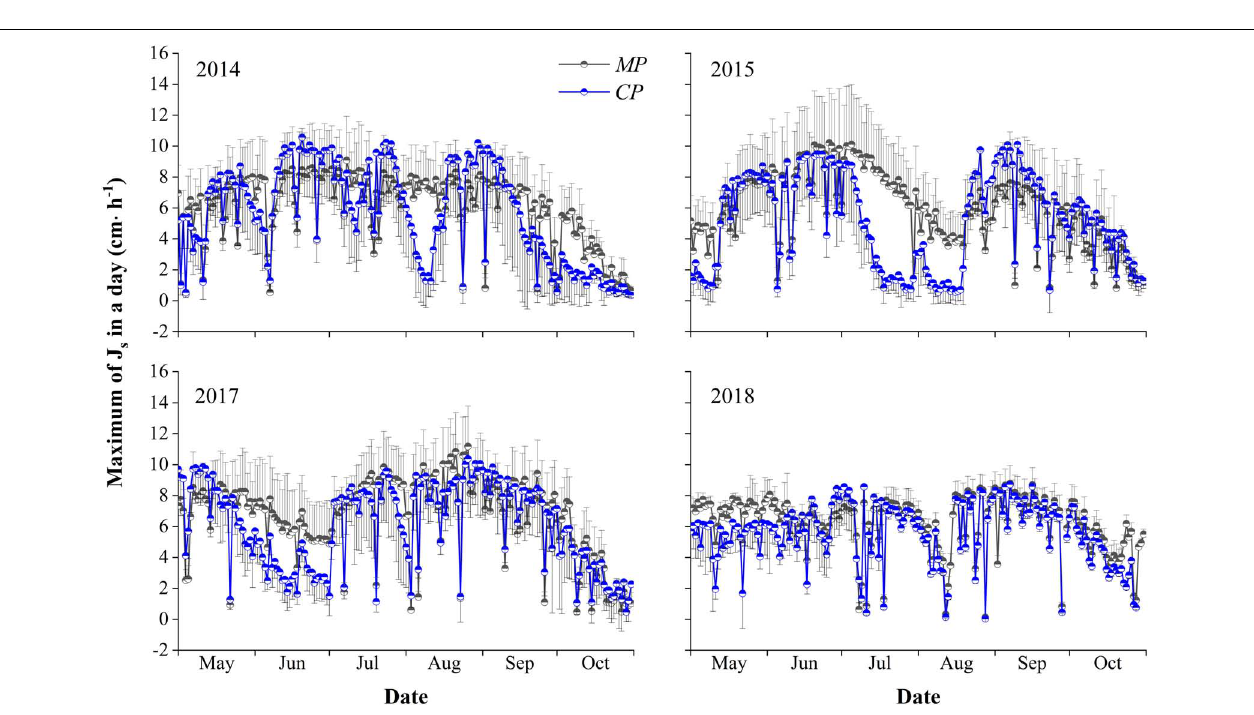
FIGURE 3 | Inter-seasonal dynamics of the maximum hourly sap flux density (J s − max , cm · h − 1 ) in a day in the 4 years of xylem sap flux measurement for the Mongolian Scots pine ( MP ) and Chinese pine ( CP ) trees. The half circle points represent the means of J s − max , and short T-type line represent error bars. Only the plus or minus direction error bars are drawn for the clartity of the